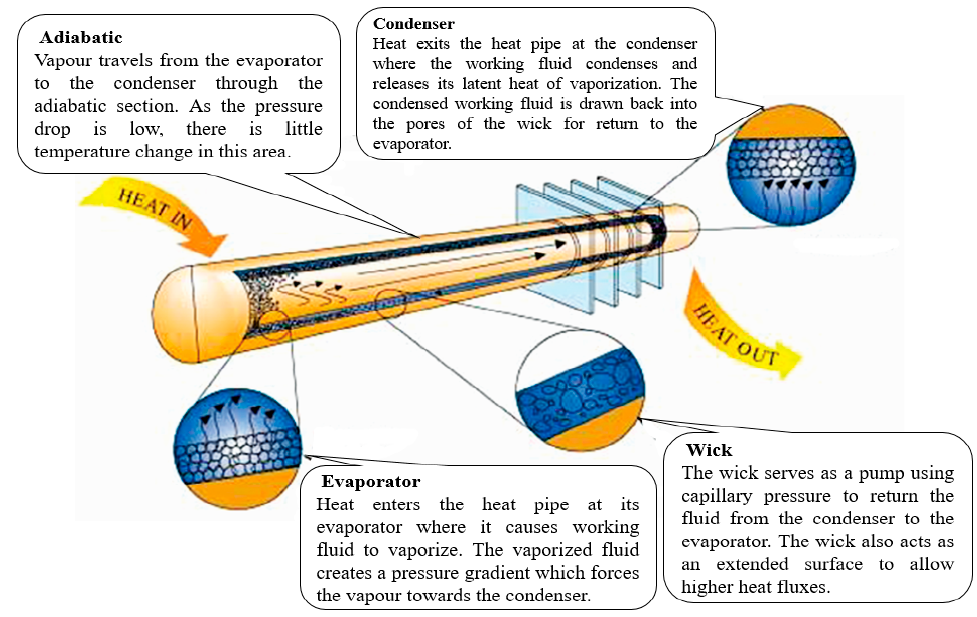
Figure 1. Heat pipe operation